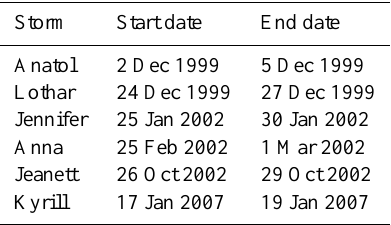
Table 5. Dates of the six most severe winter storms during the pe- riod 1997–2007 (Donat et al.,